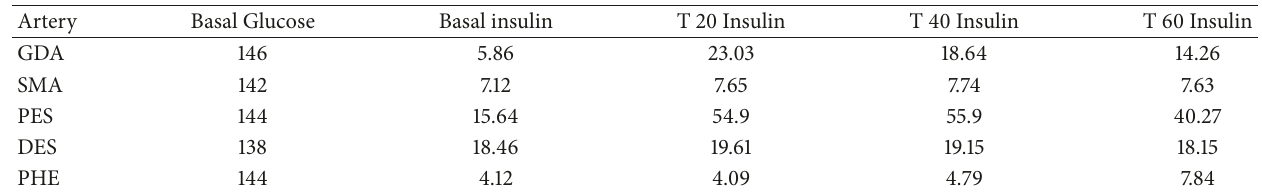
Table 2: Selective intra-arterial pancreatic stimulation with hepatic venous sampling (SACTS). In the first column we find each artery from which a sample was collected. In each artery, before injecting calcium gluconate, a basal sample of insulin and glucose was taken. We can observe how during the study, glucose levels remained stable. Gastroduodenal (GDA), upper mesenteric (SMA), proximal splenic (PES), distal splenic (DES), and appropriate liver (PHE). Units of measurement: glucose mg/dL - Insulin 𝜇 IU/ml.